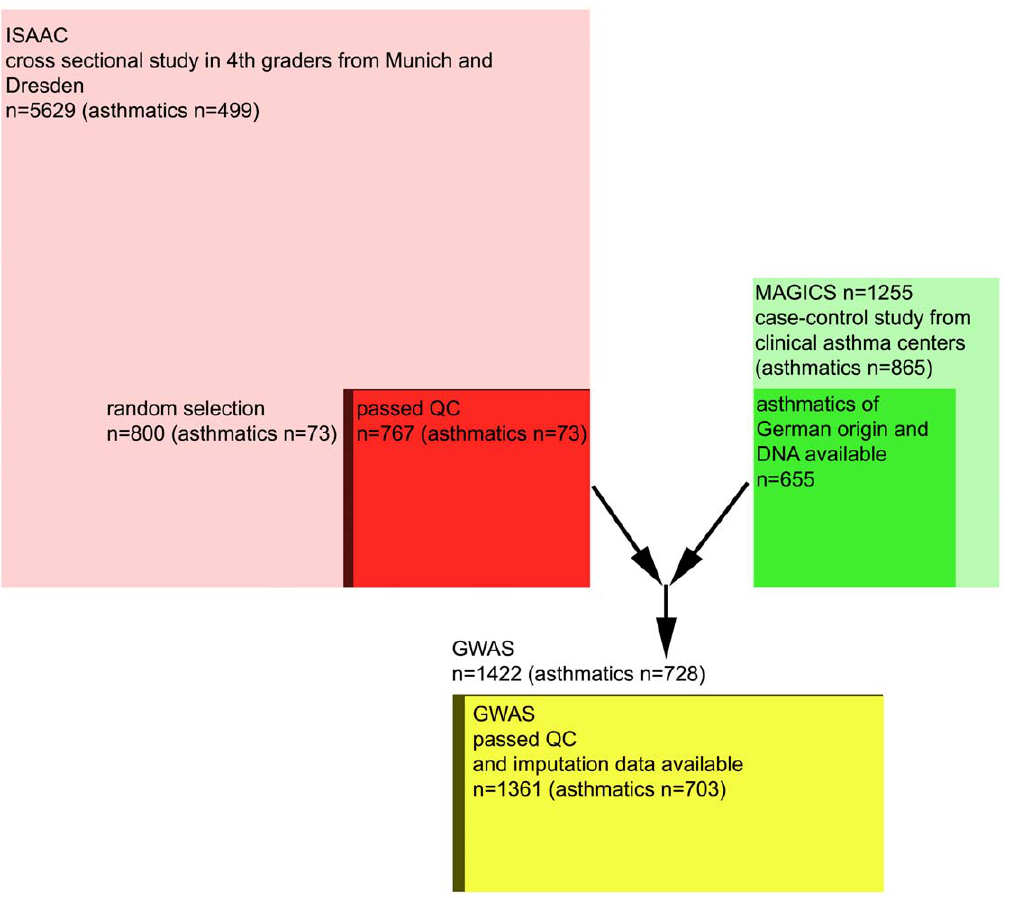
Figure 5. Study Design and population selection strategy. (ISAAC = InternationalStudyforAsthmaandAllergiesinChildhood;MAGICS = Multicentre Asthma Genetics in Childhood Study; GWAS = Genome wide Association Study; QC = quality control).